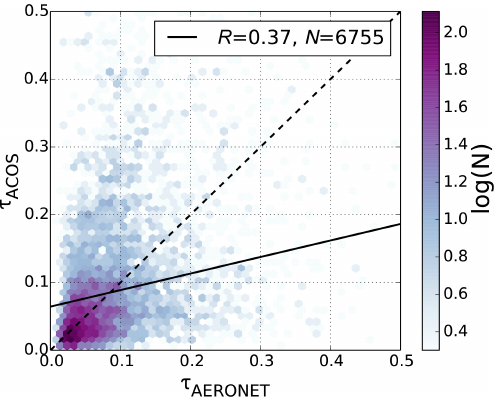
Figure 1. Heat map of AERONET aerosol optical depth compared to the retrieved ACOS B3.4 aerosol optical depth from GOSAT measurements. A linear fit is shown by the solid black